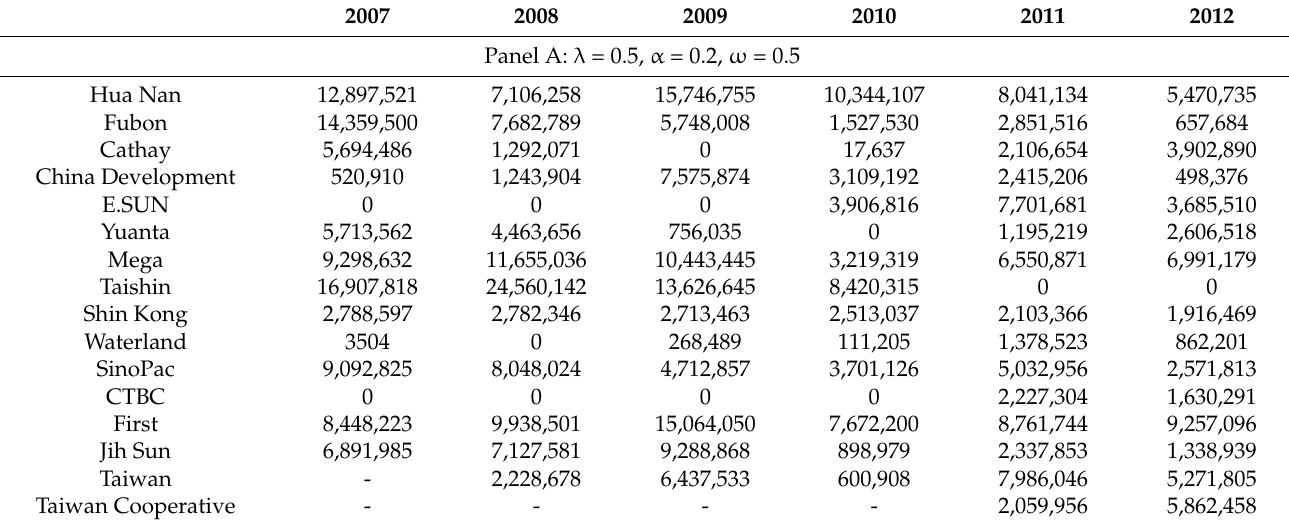
Table A1. NPLs with assumed fixed parameters ( Billion Taiwanese dollars ).